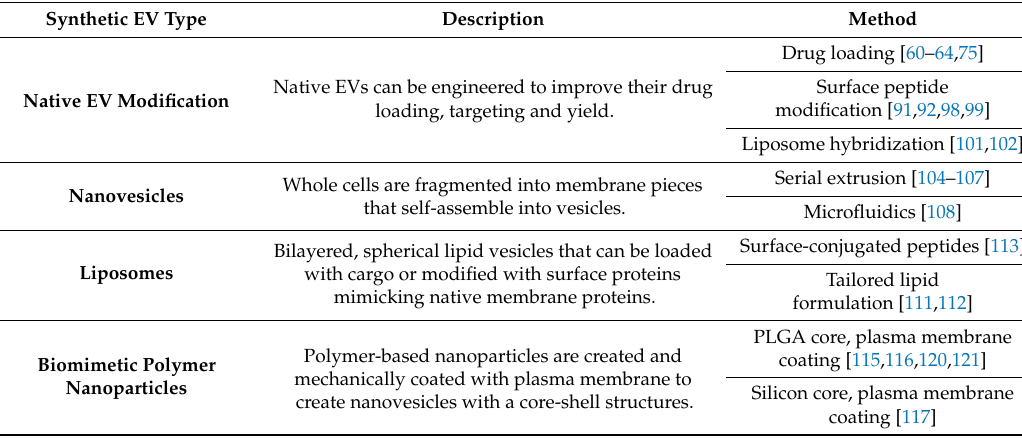
Table 2. Summary of semi-synthetic and synthetic EV-mimic